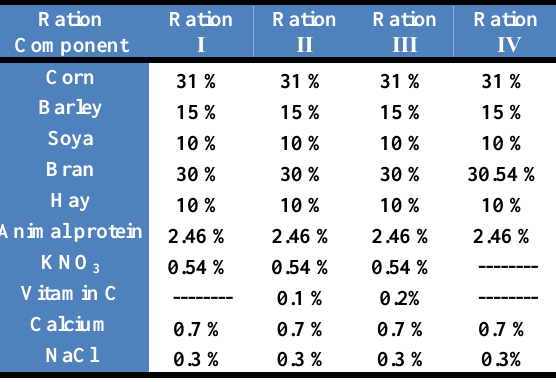
Table, 1: Different nutritional rations fed to different